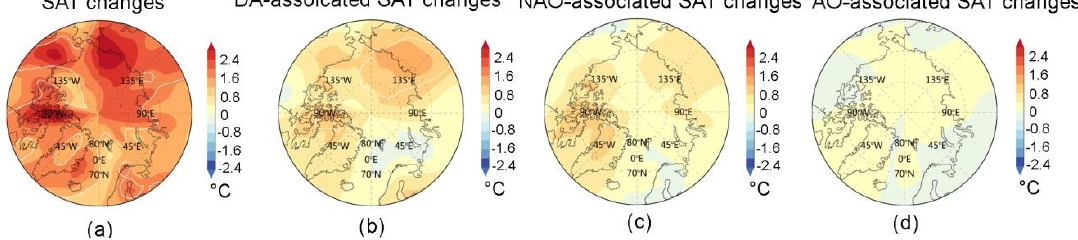
Figure 7. SAT trends ( a ) and the trends associated with ( b ) DA, ( c ) NAO, and ( d ) AO. The associated SAT trends are estimated as the regressed slope of the SAT (obtained from ERA5) on different atmospheric indices over the period 1979 – 2020.